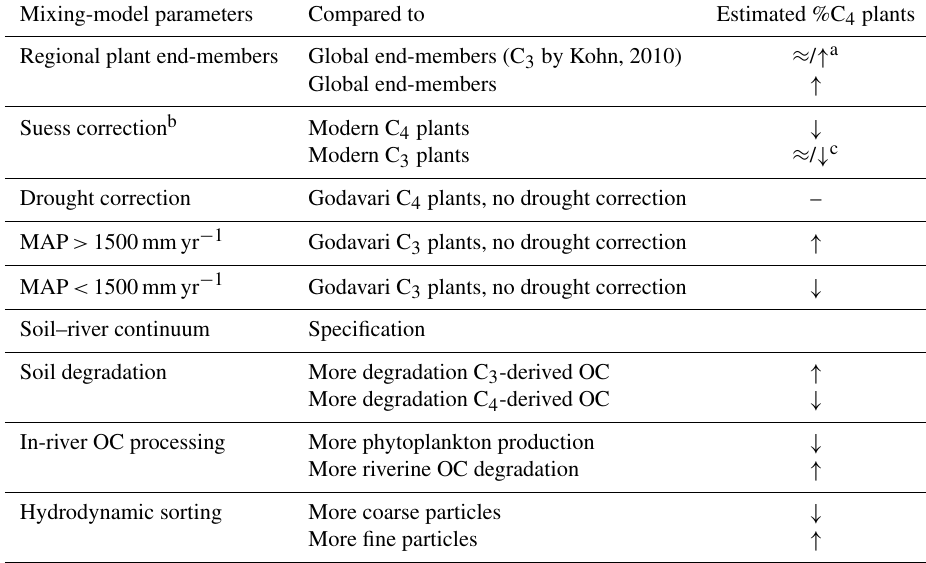
Table 2. Summary of processes/factors influencing the C 3 /C 4 mixing-model